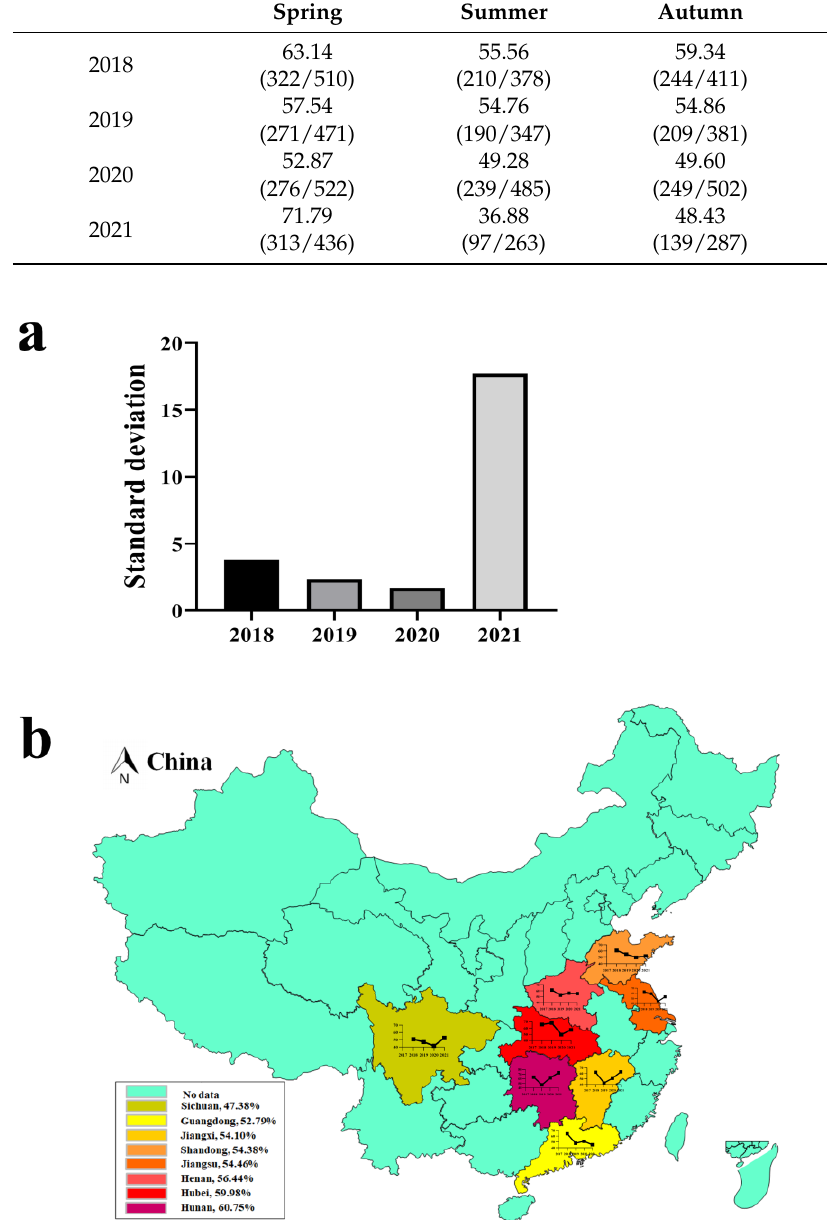
Figure 2. Seasonal characteristics and distribution of PEDV. ( a ) The standard deviation of PEDV in samples collected in different seasons from 2018 to 2021. The X -axis represents the year, and the Y -axis represents the standard deviation of the PEDV positive rate in the four seasons from 2018 to 2021. ( b ) Distribution of PEDV detection rate in eight major pork-producing provinces of China from 2018 to 2021. The yellow area indicates a low positive rate from 2018 to 2021; the red area indicates the highly endemic areas; a darker color indicates a higher positive rate. Percentages represent the overall positive rate from 2018 to 2021. The histogram indicates the positive rate in each province, and the point indicates the positive rate of PEDV in that year (Note: the map does not represent the true borders of administrative regions of China).